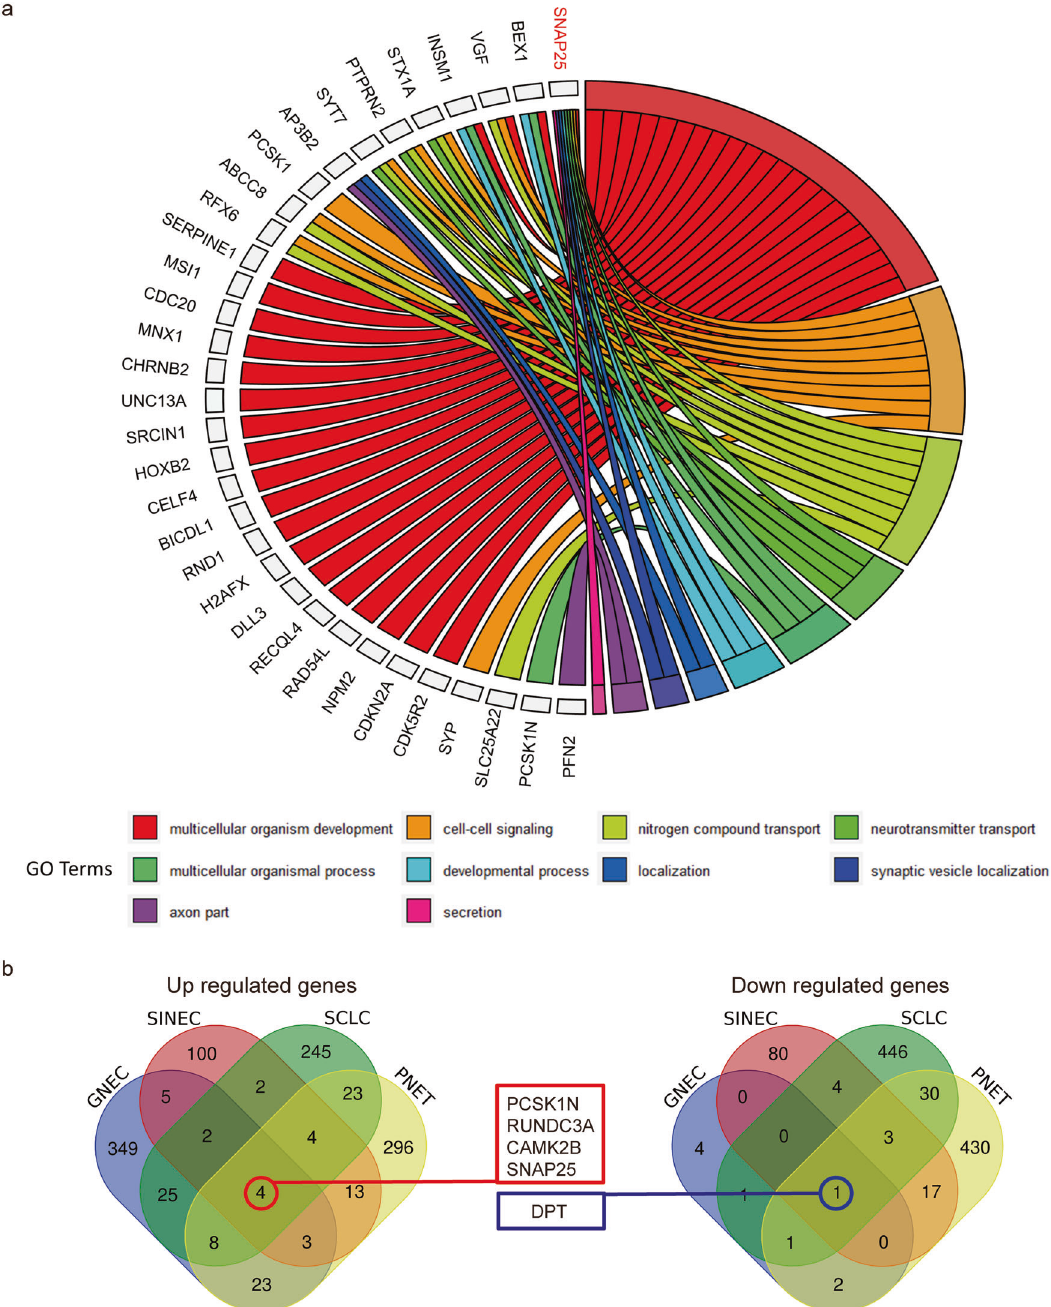
Fig. 7 Pathway enrichment pattern of DEGs in multiple NECs. a Ten enriched GO terms (except that with the highest hierarchy GO:0008150) found in GNEC and at least one in another cancer type were processed using a GOChord plot. Common genes are listed on the left side, and enriched GO terms are listed on the right side. b The Venn diagrams show the number of coregulated genes among multiple